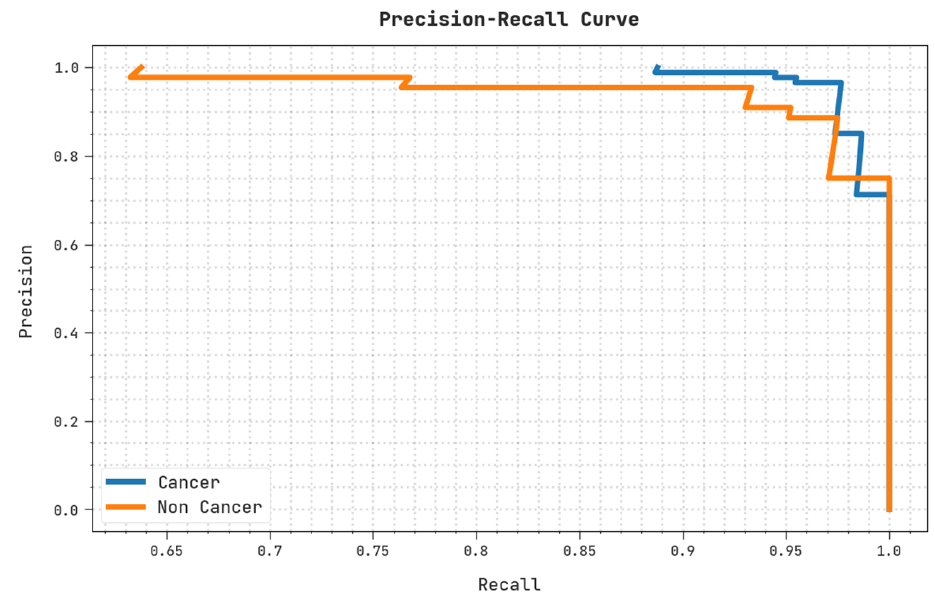
Figure 9. TRL and VLL analysis of OIDCNN-OPMDD approach.